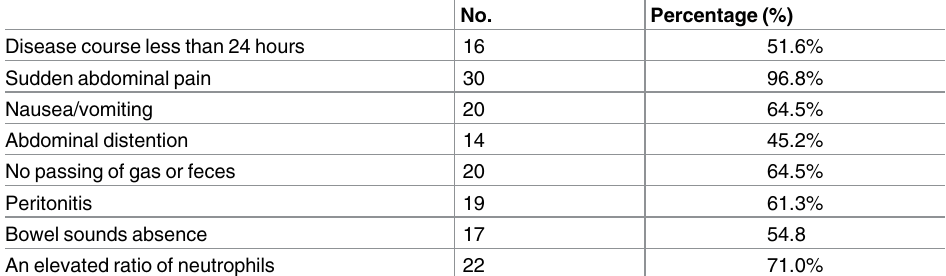
Table 2. Clinical manifestations and blood routine tests of the 31 patients with small bowel volvulus.